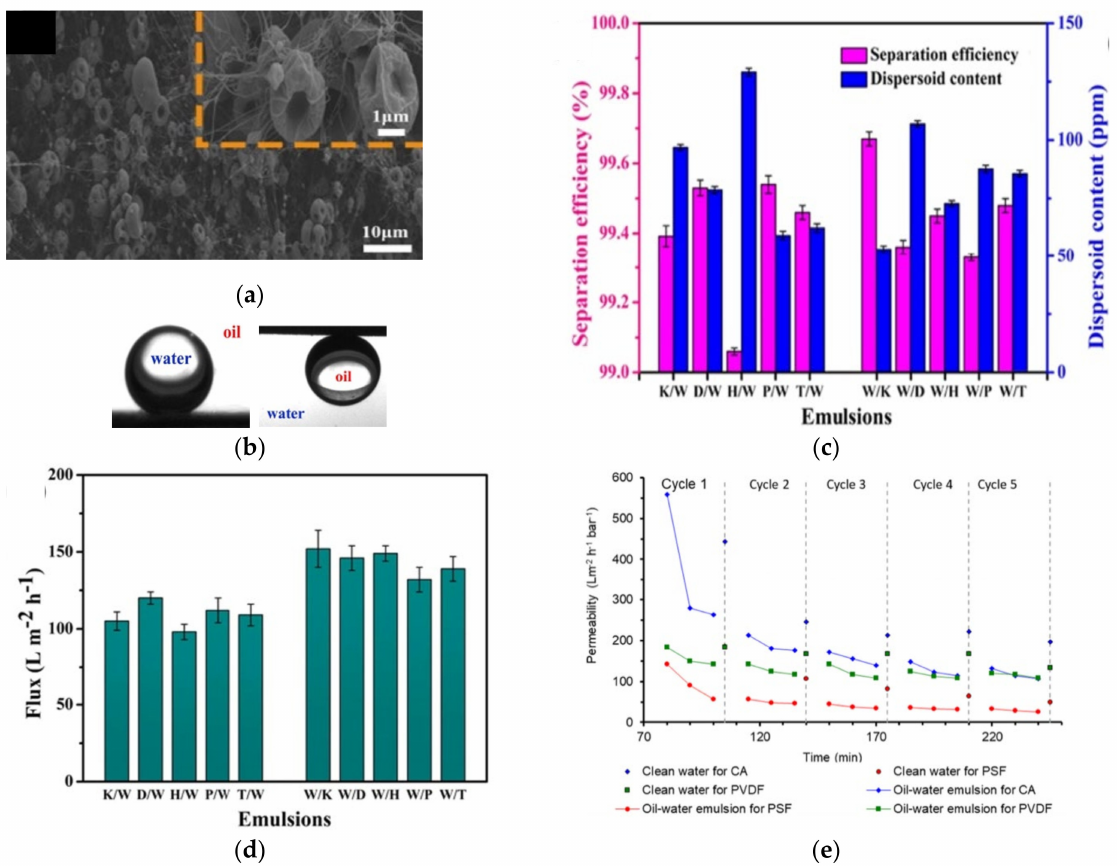
Figure 5. ( a ) Surface morphology of electrospun cigarette filters-derived CA membrane, ( b ) static oil and water droplets showing the superwettability of underwater and underoil, ( c ) separation efficiency and dispersoid content, and ( d ) filtrate flux of various oil/water emulsions (K, kerosene; D, diesel; H, hexane; P, petroleum ether; T, trichloromethane; W, water). [148] ( e ) Oil-in-water emulsion permeability of waste cigarette filter-derived CA membrane, PSF membrane, and PVDF membrane as a function of time for five cycles